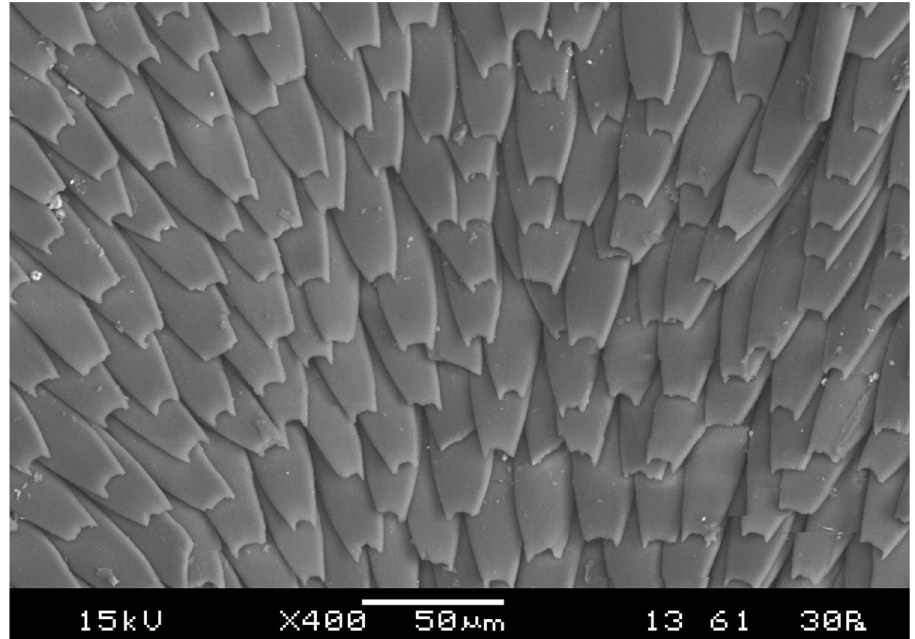
Figure 2. Scanning electron micrography of a female Lepidophthirus macrorhini, depicting the disposition of scales.